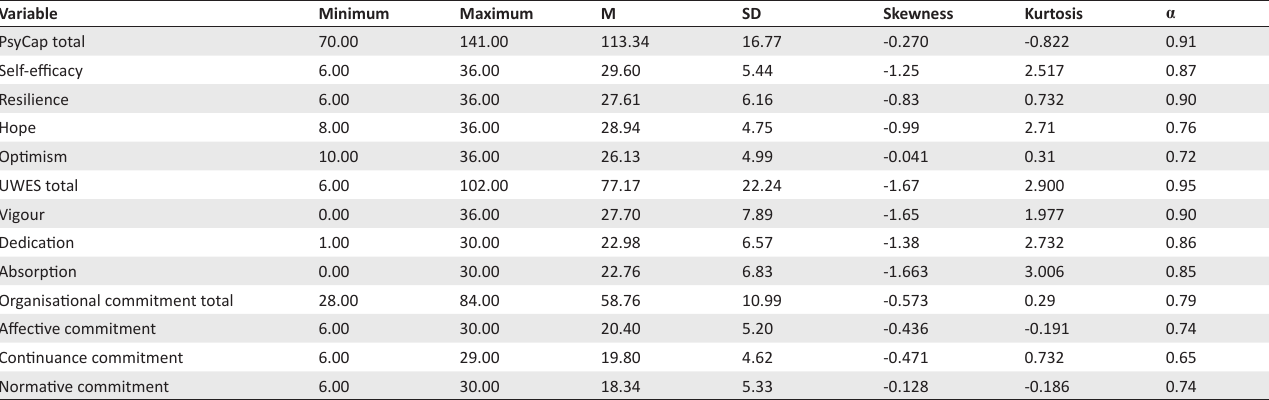
TABLE 2: Descriptive statistics.